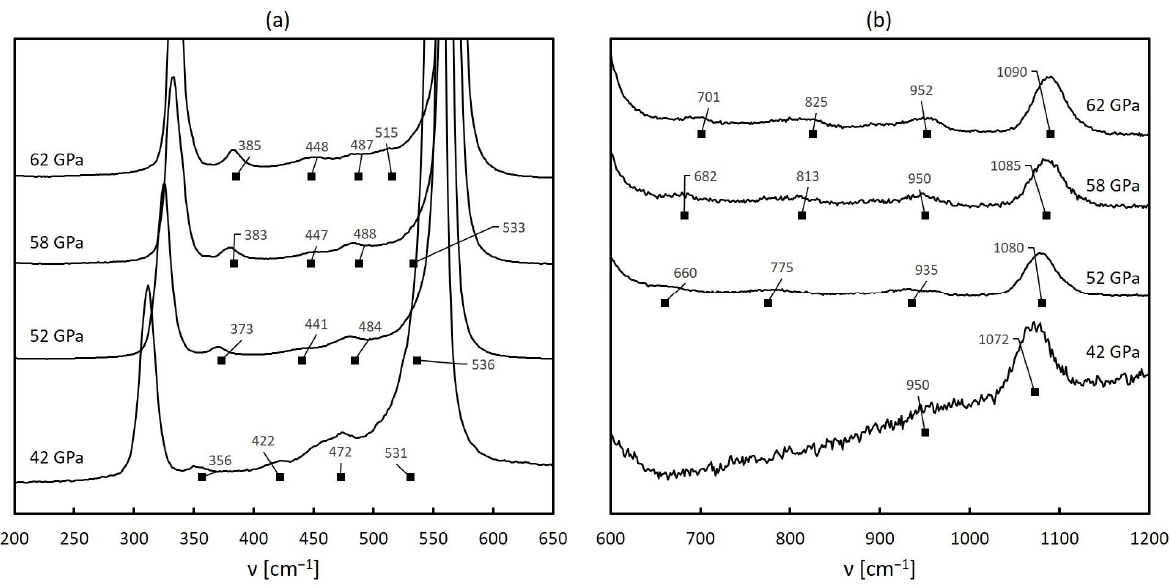
Figure 2. Comparison of spectra obtained in experiment A: AgCl + Cl 2 mixture compressed initially to ca. 40 GPa and laser-heated. ( a ) 200–650 cm − 1 range, ( b ) 600–1200 cm − 1 range. See text for further details.